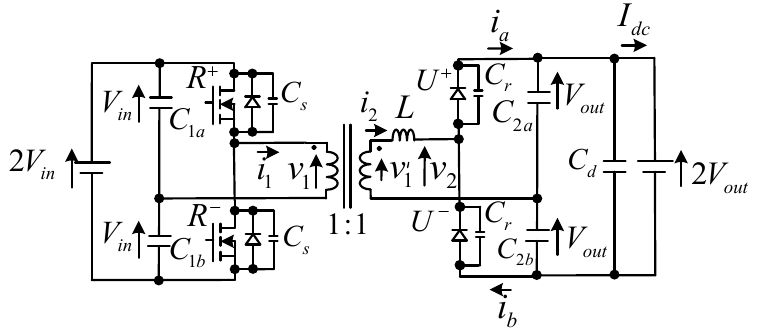
Figure 1. Proposed unidirectional secondary-resonant single-active-half-bridge DC-DC Converter.